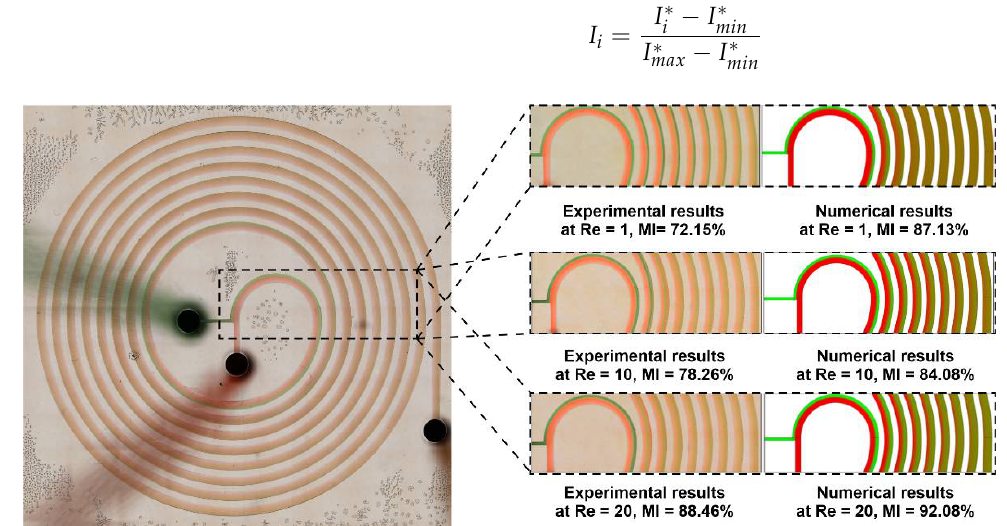
Figure 4. Numerical model validation and assessment with experiments at Re = 1, 10, and 20 using SM3. An overall view of mixing performance obtained via experimental observation ( left ) and numerical simulation ( right ). Fluids in the channel are shown in two distinct colors: green and red. The numerical errors seem to be insignificant, and the model agrees well with experiments in different situations.